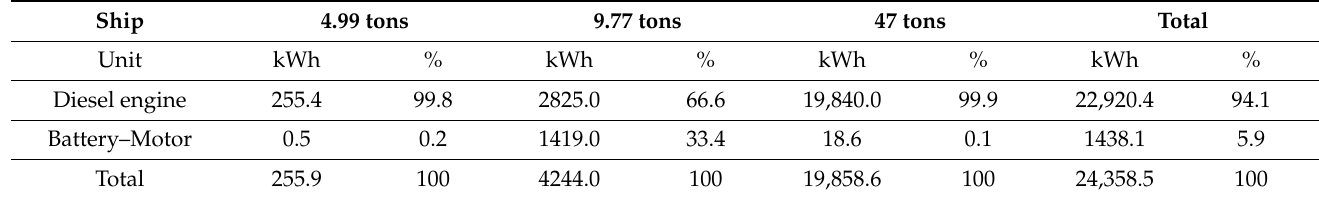
Table 2. Output of proposed battery hybrid fishing boats in idling and fishing.